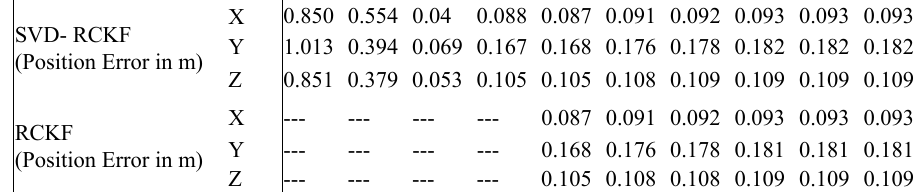
Table 3. The position errors of different strict parameter in case 1